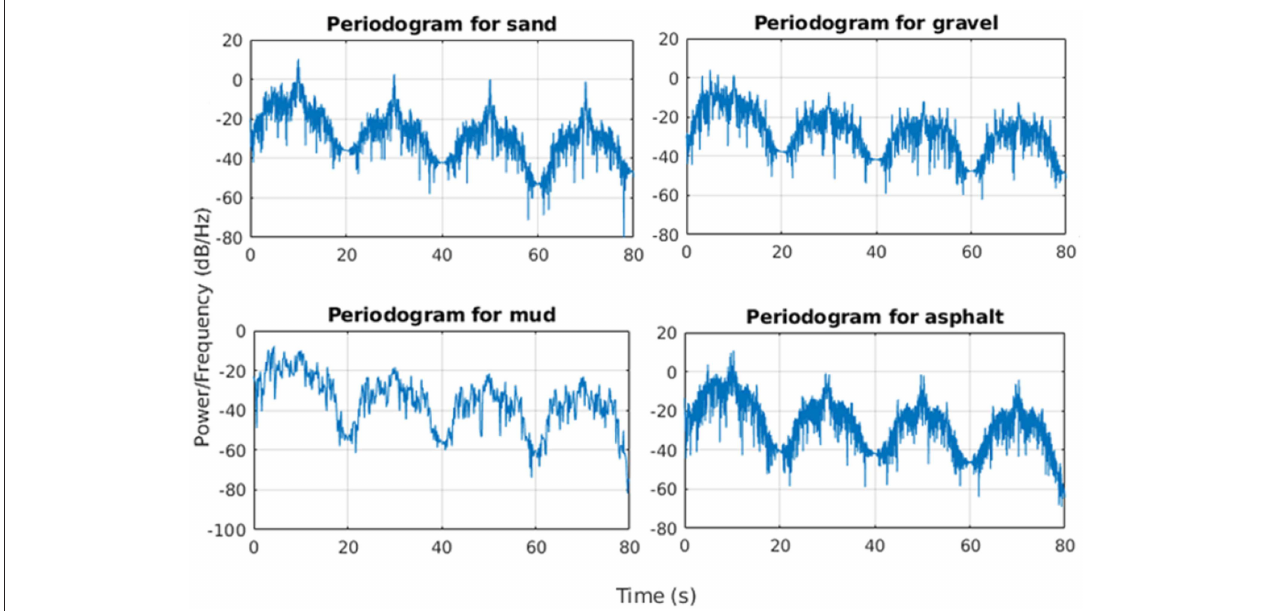
FIGURE 12 | Power spectral density values for sand, gravel, mud, and asphalt.